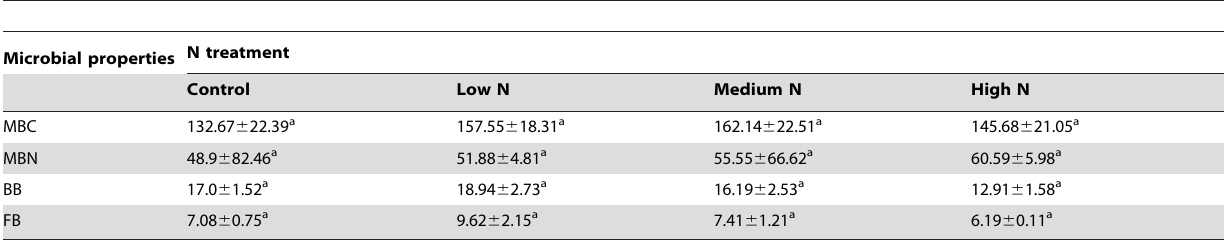
Table 1. Effects of nitrogen (N) addition on microbial biomass carbon (MBC), microbial biomass N (MBN), bacterial biomass (BB), and fungal biomass